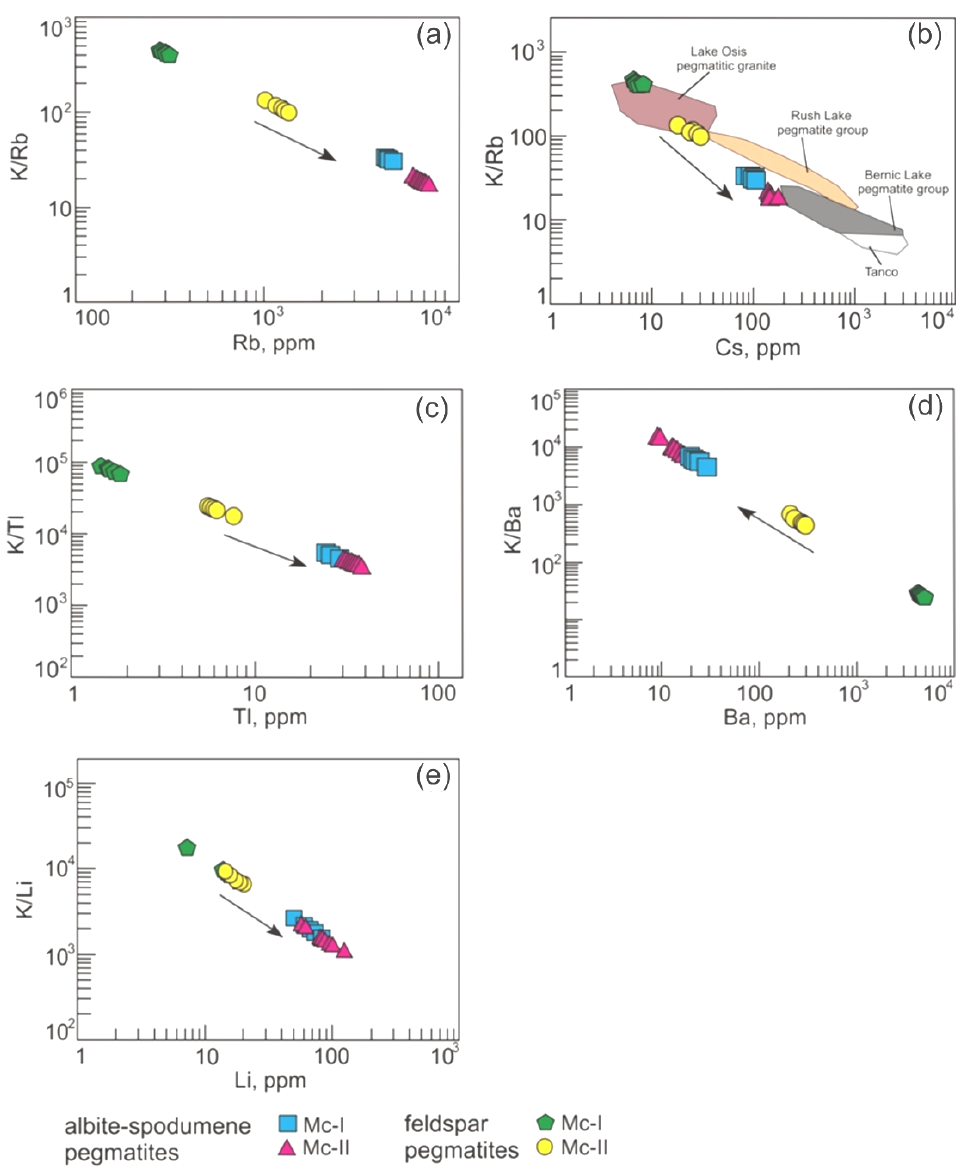
Figure 8. ( a ) Plots of K/Rb vs. Rb; ( b ) K/Cs vs. Cs (feldspars from Bernic Lake pegmatite group, Tanco pegmatite, Rush Lake pegmatite group, and Lake Osis pegmatitic granite are from Goad and Černý [39]); ( c ) K/Tl vs. Tl; ( d ) K/Ba vs. Ba; ( e ) K/Li vs. Li. In K-feldspars, K/Ba ratios and the contents of Rb, Cs, Tl, and Li increase, while K/Rb, K/Tl, and K/Li element ratios and the contents of Ba decrease from feldspar pegmatites to albite-spodumene pegmatites. Similar trends are observed from early to late generations of K-feldspar.